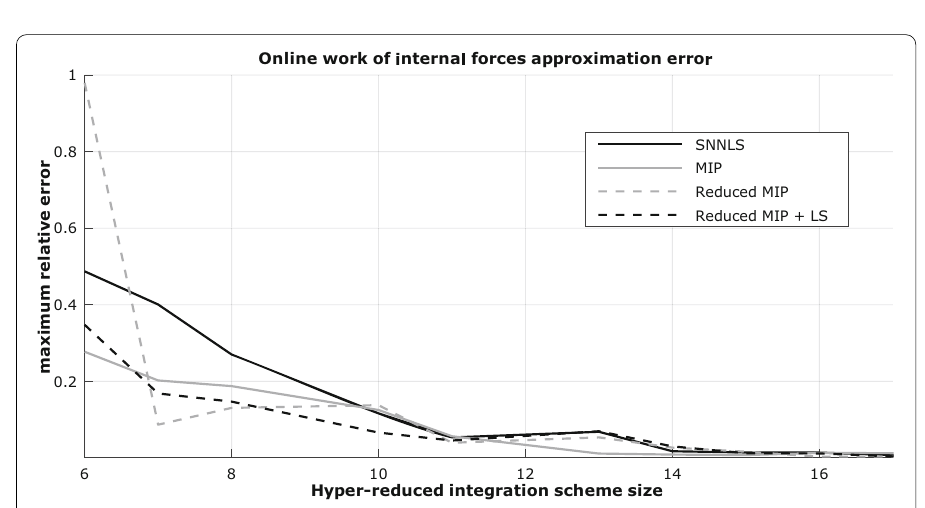
Fig. 12 Online work of internal forces approximation error (35) of SNNLS and proposed hyper-reduced integration schemes. Hyper-reduced integration schemes sizes range from 6 to